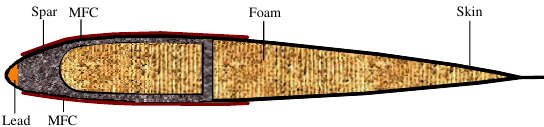
Fig 3. MFC actuator